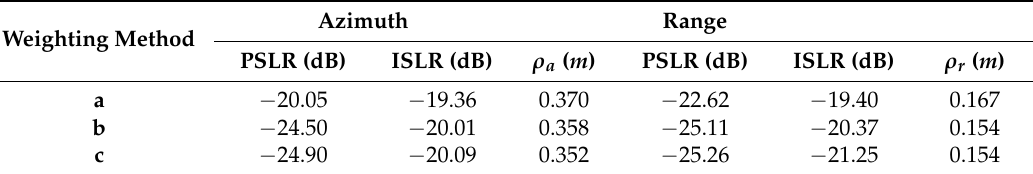
Table 2. Results of the imaging algorithm with three weighting